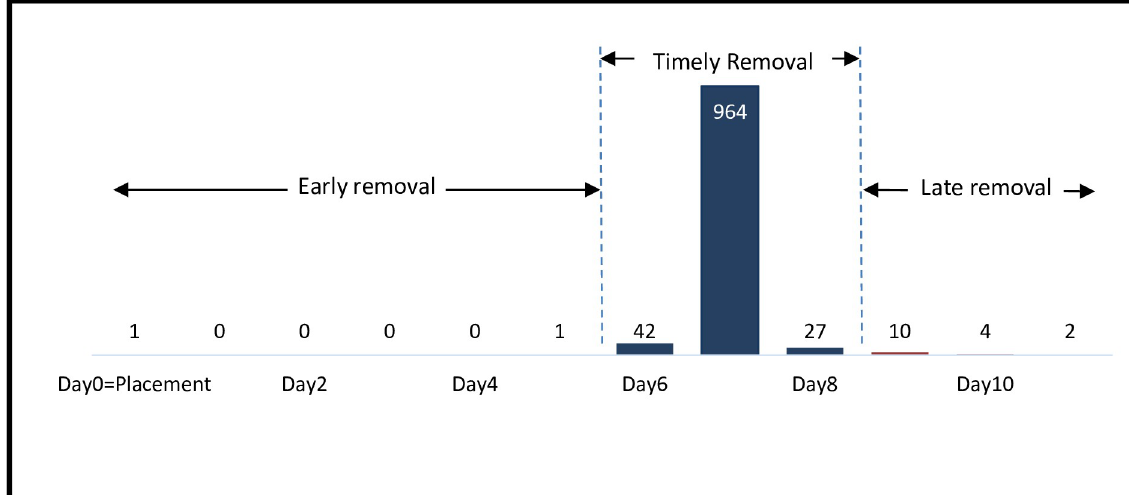
Fig 2. Number of ShangRing removals by day since